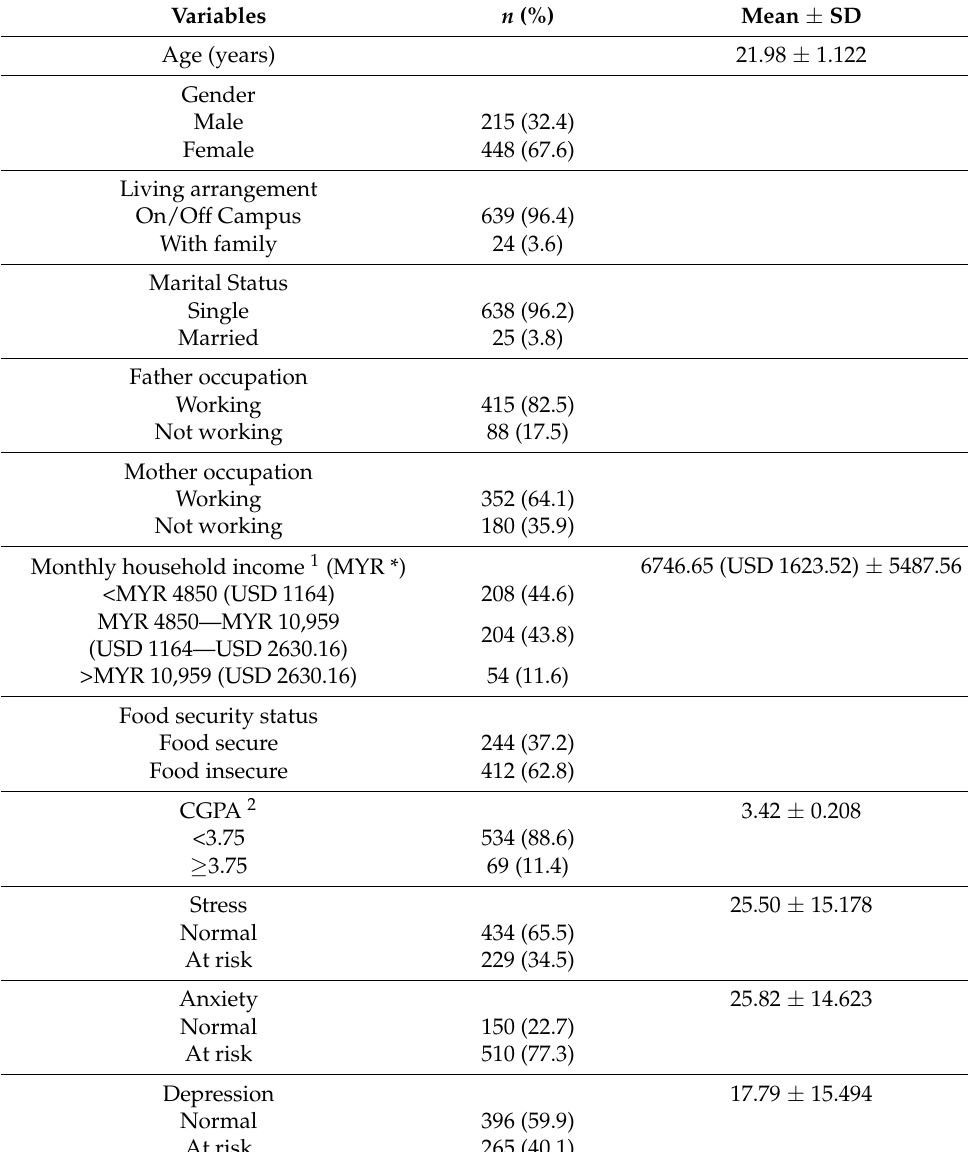
Table 1. Characteristics of